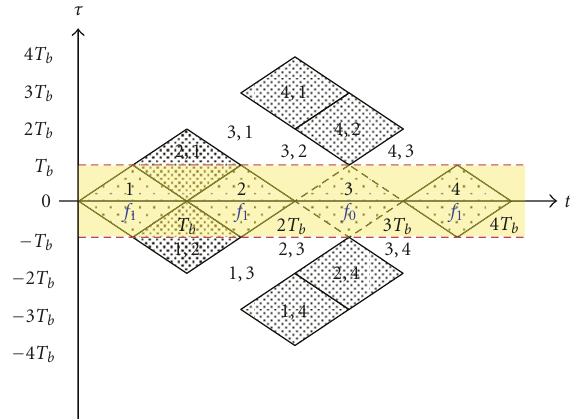
Figure 2: Bilinear product of ASK signal. The bilinear products beyond the shaded area are